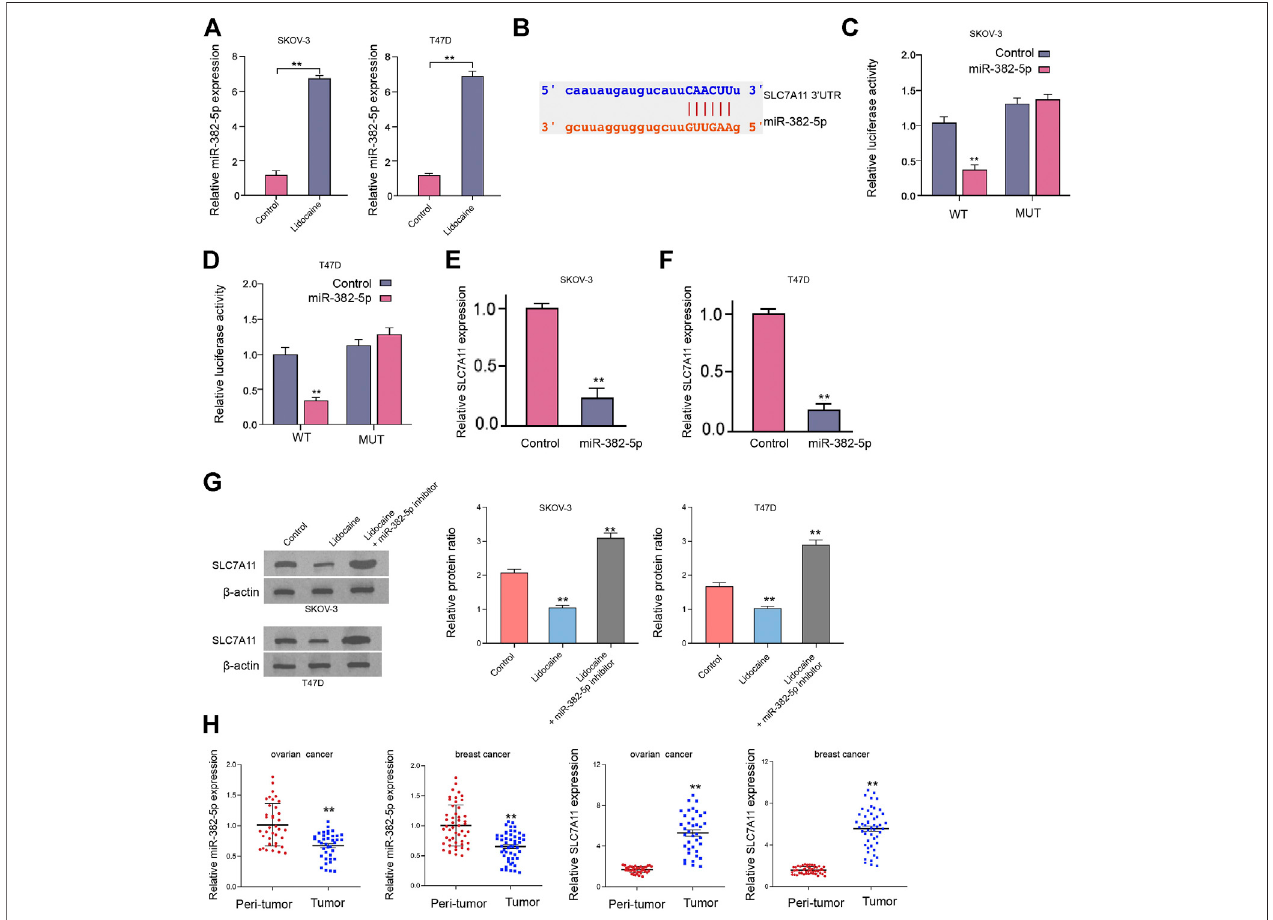
FIGURE4| LidocaineinhibitsSLC7A11expressionbyupregulatingmiR-382-5p. (A,B) SKOV-3andT47Dcellsweretreatedwithlidocaine(3 mM).Theexpression of miR-382-5p was analyzed by qPCR assays. (C – F) SKOV-3 and T47D cells were treated with miR-382-5p mimic. (C,D) The luciferase activity of SLC7A11 mRNA 3 ’ UTR was analyzed. (E,F) The mRNA levels of SLC7A11 were examined by qPCR. (G) The protein expression of SLC7A11 was detected by Western blot analysis in SKOV-3 and T47D cells co-treated with lidocaine and miR-382-5p inhibitor. (H) The expression of miR-382-5p and SLC7A11 was detected by qPCR in clinical ovarian cancer tissues ( n (cid:2) 38) and breast cancer tissues ( n (cid:2) 50) and the related adjacent tissues. mean ± SD, ** p < 0.01. The experiments were performed independently three times.